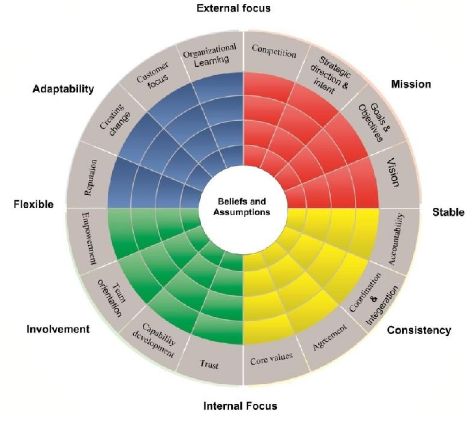
Fig. 3. Mapna’s Model of Diagnosing Organizational